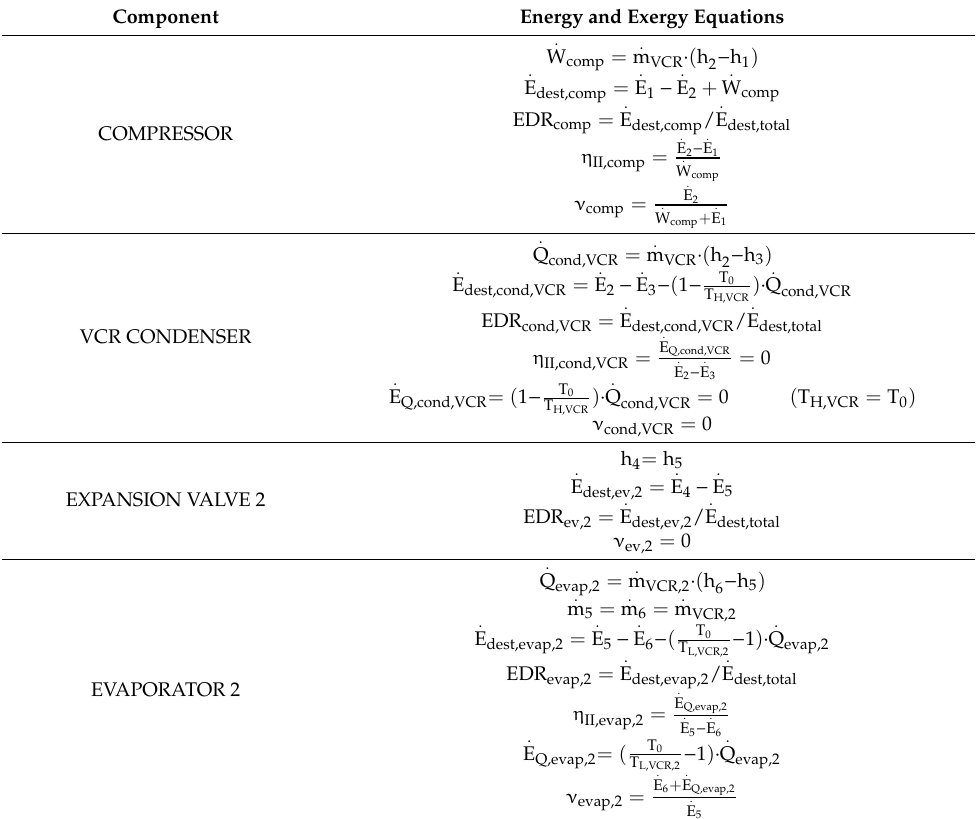
Table 6. Equations for VCR cycle components in combined ORC-dual evaporator VCR cycle.